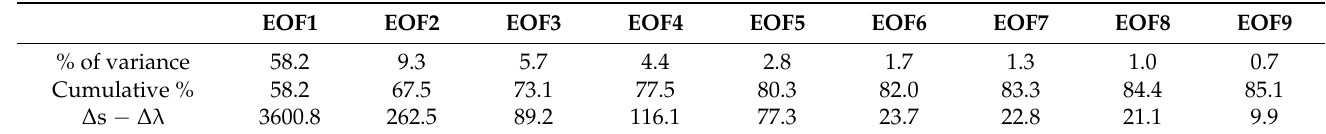
Table 2. Variance contribution (%) of the retained EOFs before rotation, and the difference between the spacing of adjacent eigenvalues ( ∆ s) and the sampling error ( ∆ λ ), for the retained EOFs tested by North’s Rule of Thumb.